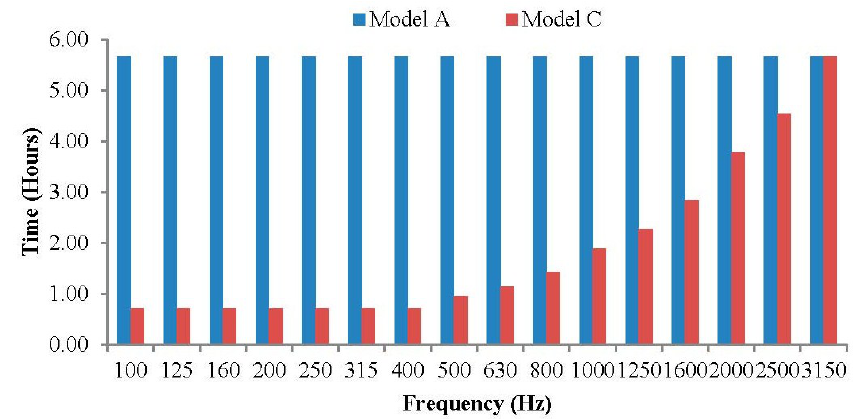
Figure 9. Comparison in solution time between the constant mesh (Model A) and frequency dependent mesh (Model C) at one-third-octave bands.